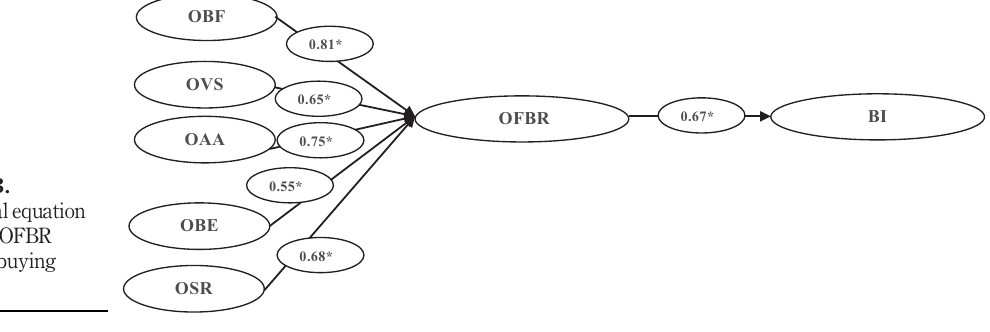
model of OFBR towards